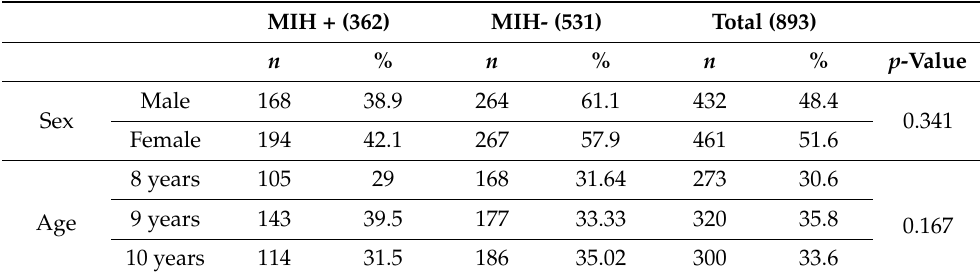
Table 2. MIH distribution according to age and